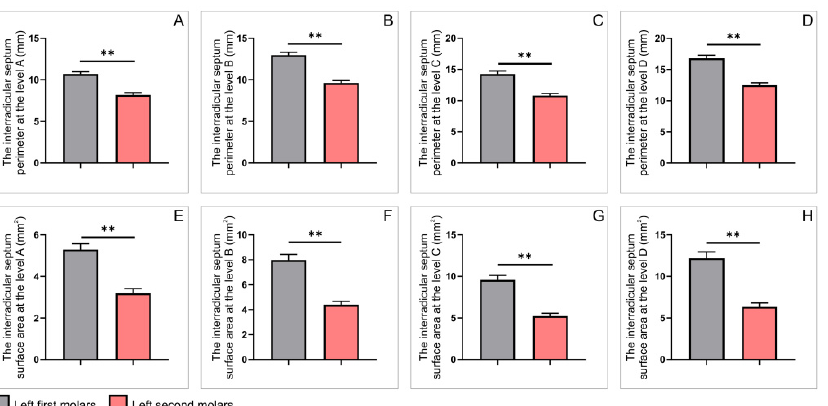
Figure 8. The parameters obtained on axial slices for upper molars on the left side: ( A – D ) the interradicular septum perimeter (in mm) at the levels A–D, respectively; ( E – H ) the interradicular septum surface area (in mm 2 ) at the levels A–D, respectively. Values are expressed as the mean ± SEM. ** Denotes a significant difference, p < 0.01.